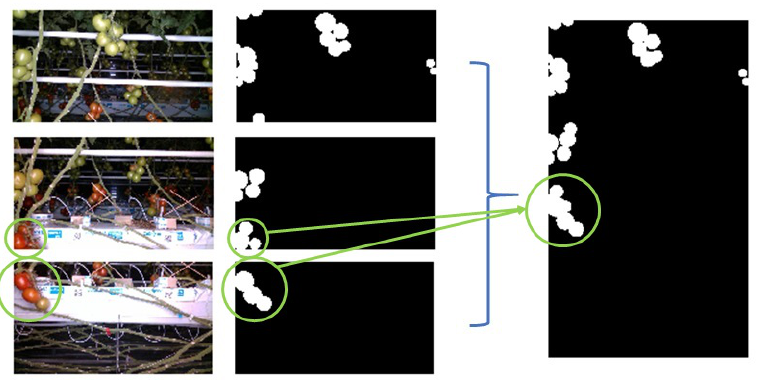
Figure 7. Example of vertical registration. The three images in the left column are original RGB images of the three cameras at one position in the row. The middle column shows the detected fruits at each camera position. The right column shows the integrated column image, with good integration of the overlapping trusses. Note that the dimensions of column image are different as they incorporate the overlap between the images, which decreases the vertical size with respect to the sum of the vertical size of the 3 camera images.